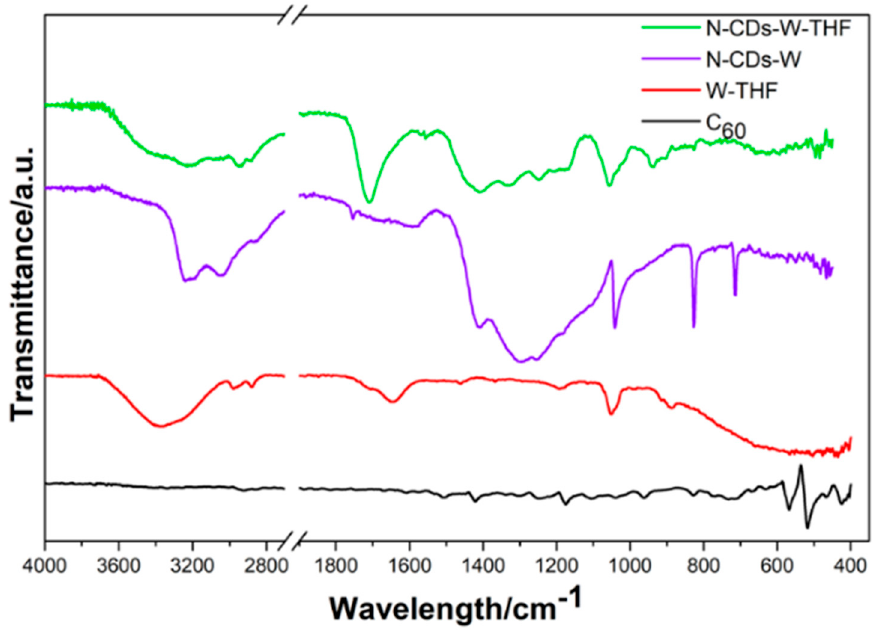
Figure 1. Infrared spectra of pristine fullerene-C 60 (black solid line), mixture water-THF (red solid line), N-CDs-W (violet solid line), and N-CDs-W-THF (green solid line). The samples were deposited on clean Al foil by drop casting prior to the measurement.